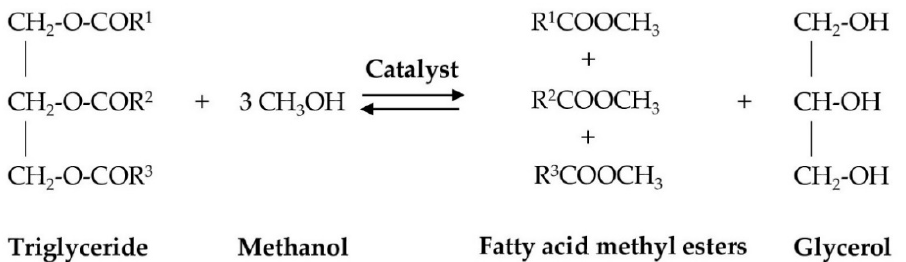
Figure 2. Transesterification reaction of triglycerides with methanol to synthesize biodiesel and glycerol.